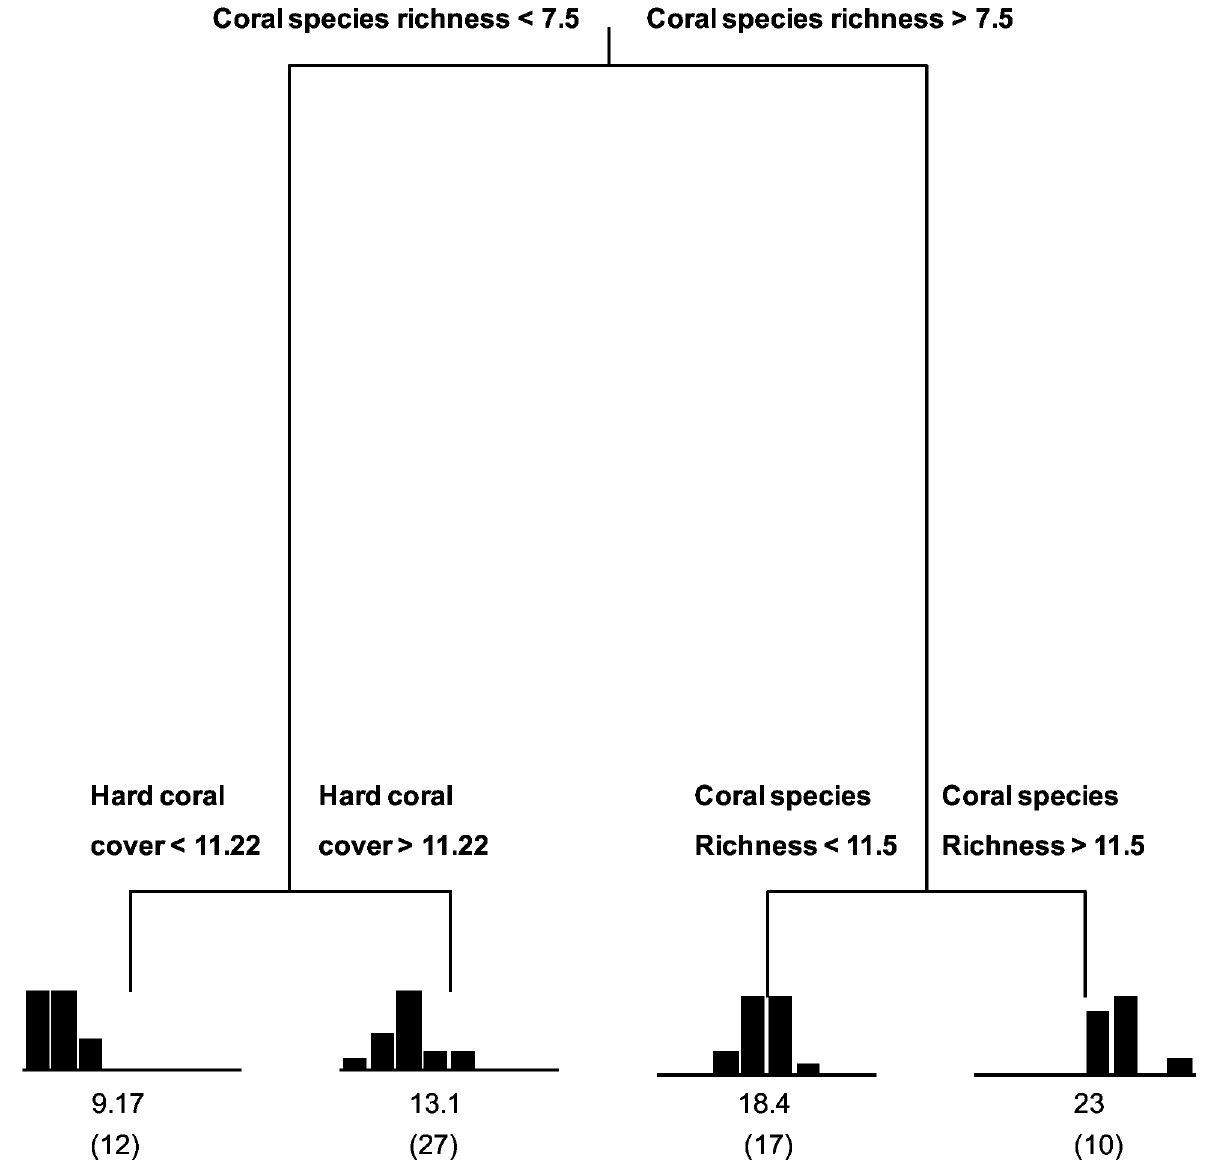
Figure 4. Regression tree analysis of the fish species richness at Lizard Island, QLD, Australia. The explanatory variables were: site, topographic complexity, habitat diversity, coral species richness, coral diversity, percent hard coral cover, branching coral cover and corymbose coral cover. For each of the four terminal nodes the distribution of the observed values of fish species richness is shown in a histogram. Each node is labeled with the mean rating and the number of observations in a group (in parentheses). The tree explained 70.5% of the total variability in the data. The first and second splits based on coral species richness explained 56.4% and 7.2% respectively, the third split based on percent hard coral cover explained additional 6.9%.